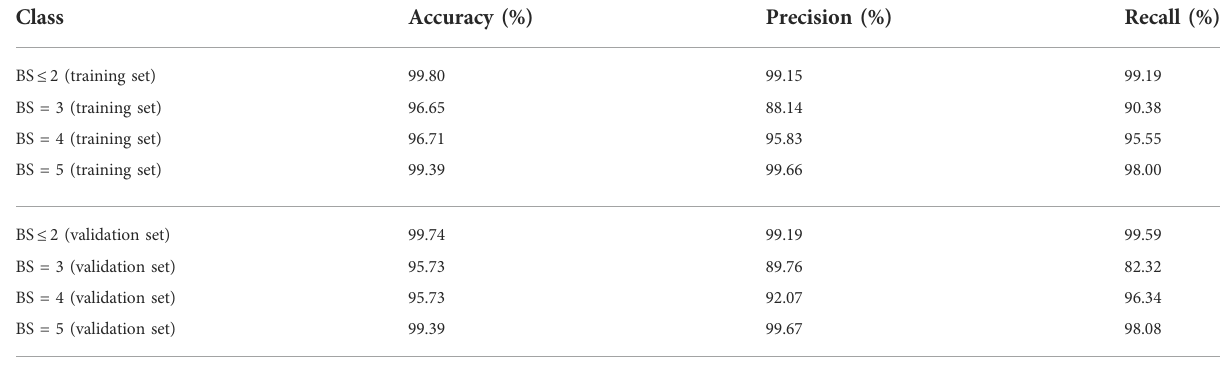
TABLE 3 Accuracy, precision, and recall in each class. BS represents the BASED score.